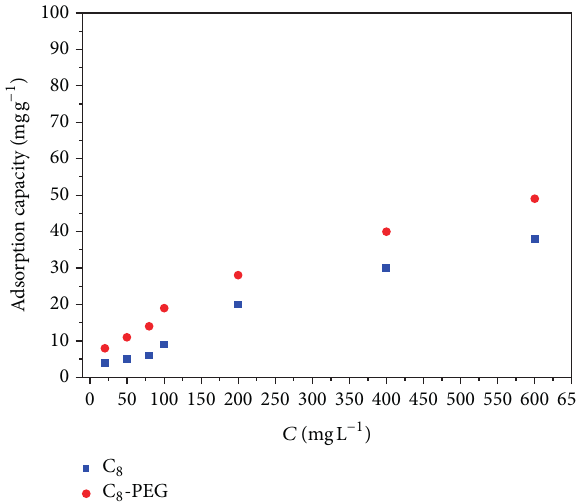
Figure 6: Static adsorption of SMR with C 8 and C 8 -PEG.